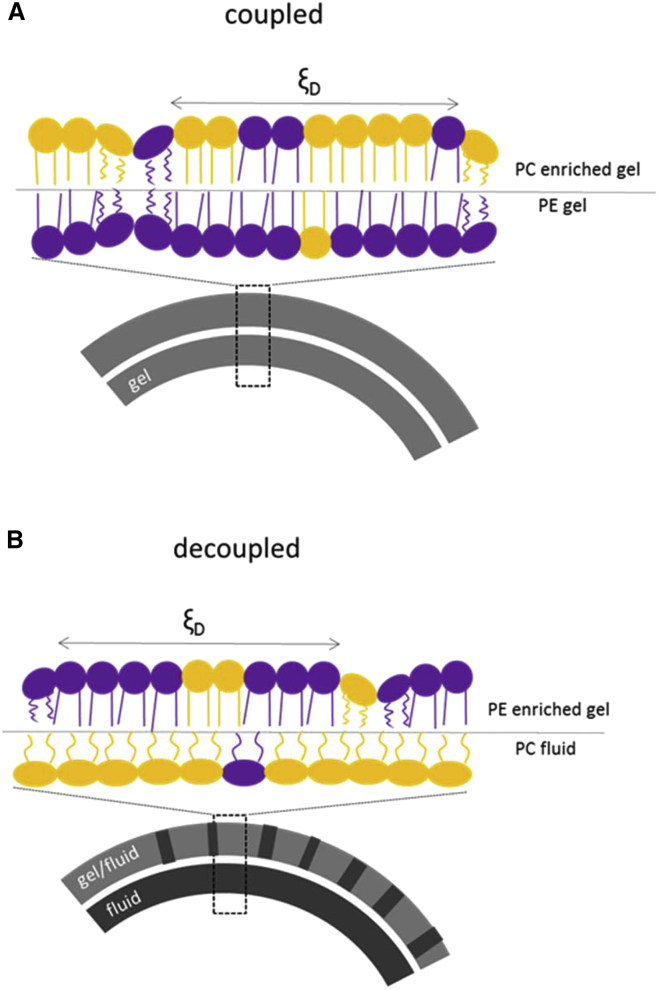
Schematic lipid distribution and transbilayer coupling in POPCout/POPEin (A) and POPEout/POPCin aLUVs (B). To see this figure in color, go online.